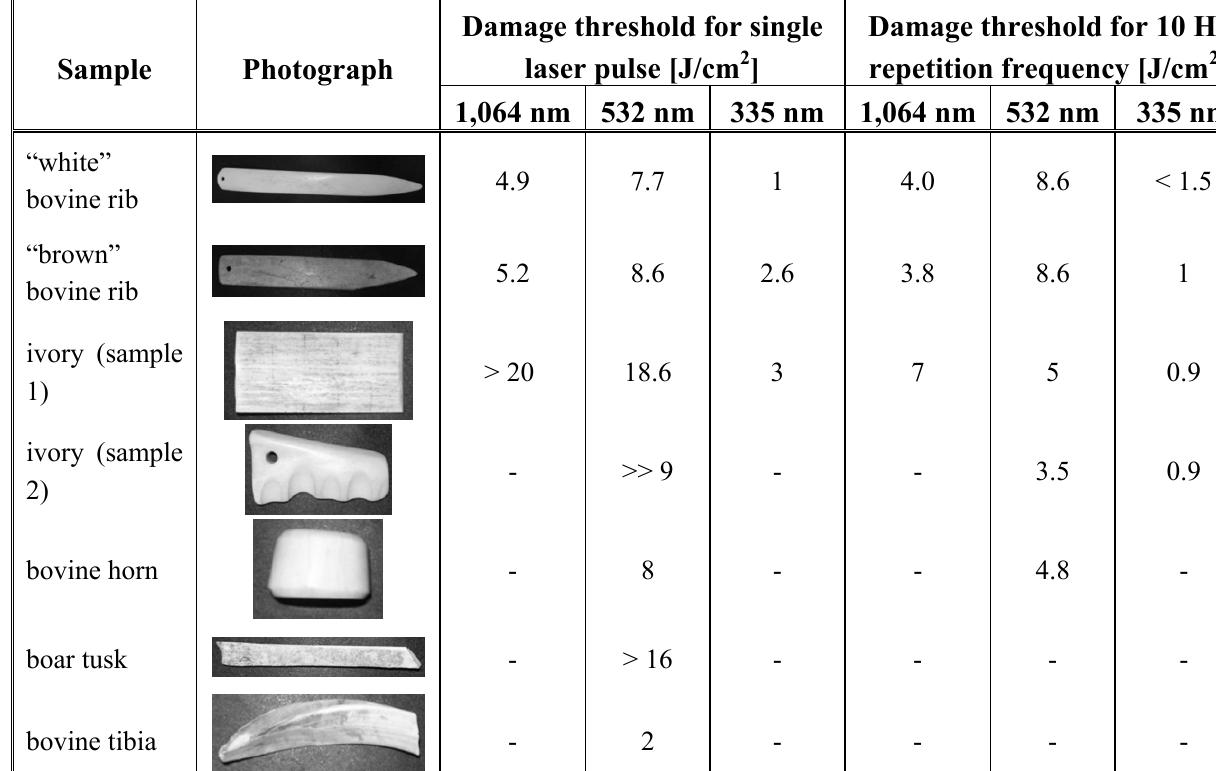
Table 4. Damage thresholds of tested bone